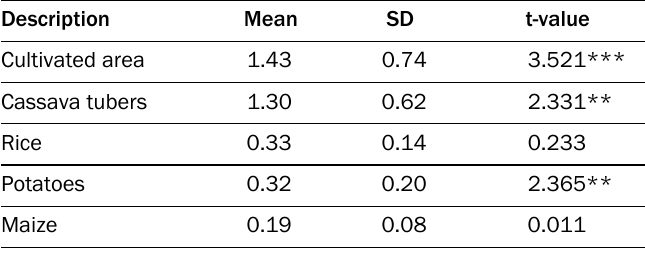
Table 3. Land Holdings and Cropping Patterns of Households (Acres)